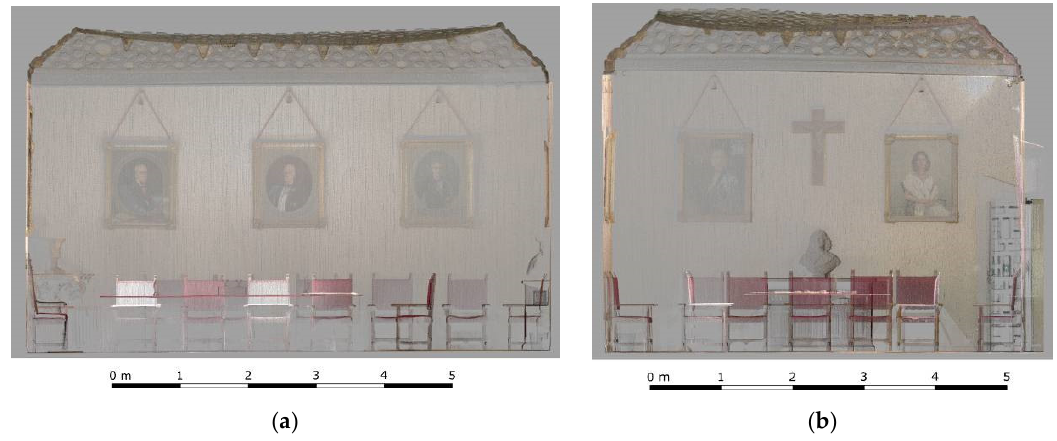
Figure 16. Sections through the mezzanine centre: ( a ) Longitudinal. ( b ) Transversal. To quantify the magnitudes of the main deformations, three longitudinal sections (parallel to the longest sides of the room) were made and different heights were sampled therein, whereby the most significant data was chosen (Figure 17).